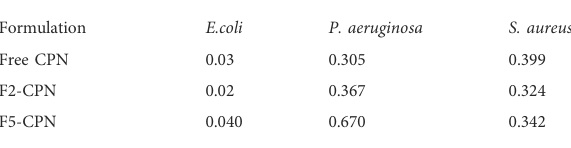
TABLE 5 In vitro action of free CPN and CPN incorporated in SEDDS against E.coli, P. aeruginosa, and S. aureus. MIC